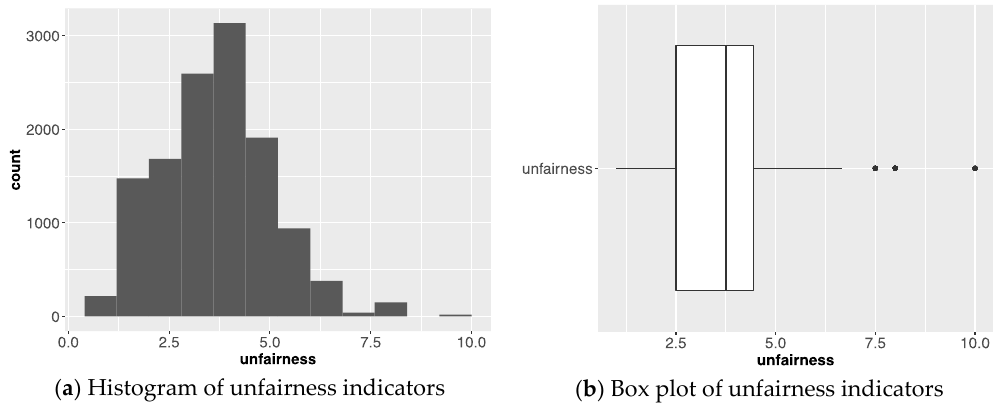
Figure 6. The distribution of unfairness indicators.